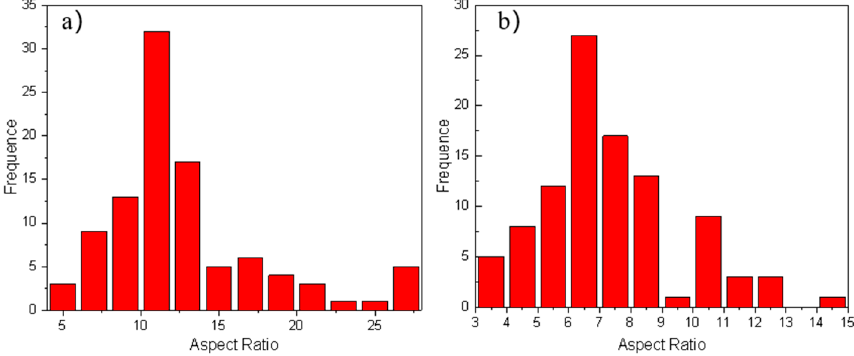
15 of 17 Figure 13. The schematic diagrams of the deformation of the original squeeze casting: ( a ) Aluminum matrix composites during tension; ( b ) Aluminum matrix composites during upsetting. The aspect ratio of the whiskers of aluminum matrix composite was measured by SEM Photographs with high magnification, as shown in Figure 14. It can be seen that the aspect ratio decreases after extrusion due to the fracture of part of the whiskers. As a result of the specific orientation and the decrease of the aspect ratio of the whiskers, a large number of whiskers are under uniform stress field during tension and only a small part of the whiskers rotate or break, which results in better plastic deformation ability and higher elongation of the aluminum matrix composite, as shown in Figure 15. Although the extruded aluminum matrix composites show higher elongation in tensile test, the di-